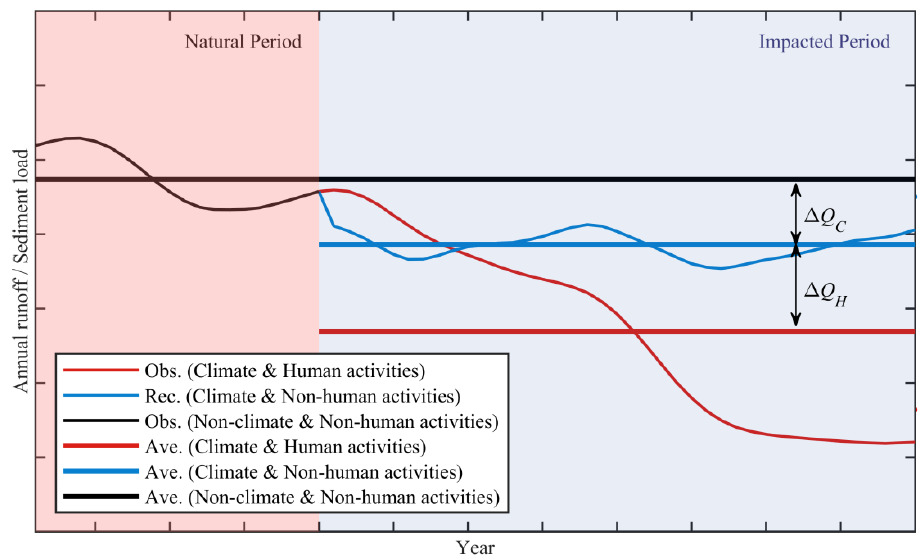
Figure 2. A graphical illustration of quantifying the impacts of climate change and human activities on annual runoff or sediment load.